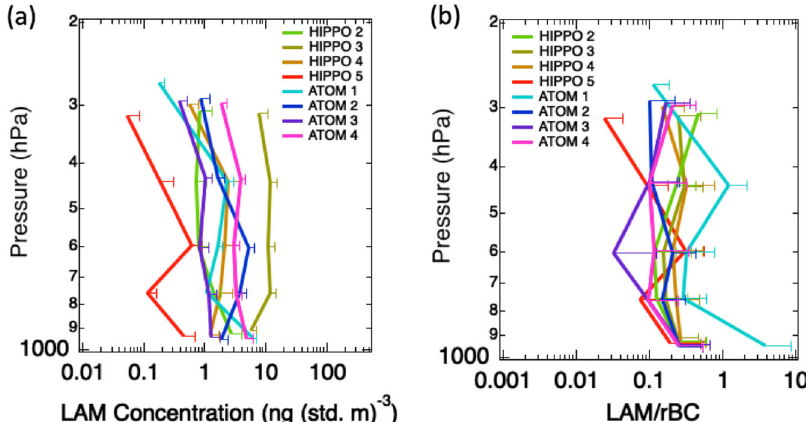
Fig. 4 Seasonality of LAM and LAM/rBC over the N. Hemisphere Paci fi c. Average vertical pro fi les for the remote Paci fi c between 20°N and 60°N for different seasons from the HIPPO and ATom campaigns are shown. LAM concentration ( a ) is given in ng (std. m) − 3 . The total number of observed LAM vertical sampling periods included in the average vertical pro fi le for each campaign is given in parentheses after the campaign name and observation period: HIPPO 2 — Oct./Nov. 2009 (34); HIPPO 3 — March/April 2010 (35); HIPPO 4 — June/July 2011 (36); HIPPO 5 — Aug./Sept. 2011 (35); ATom 1 — July/Aug. 2016 (11); ATom 2 — Jan./Feb. 2017 (31); ATom 3 — Sept./Oct. 2017 (26); ATom 4 — April/May 2018 (22). Observations are binned to 160 hPa, and error bars indicate 1 standard deviation and are only shown for the higher range (assuming observations in a single bin are normally distributed). To determine vertical pro fi les of the ratio of LAM/rBC from observations ( b ), average vertical pro fi les for LAM and rBC are calculated for each season and then divided to determine the ratio at each altitude level, as we assume that remote regions are well-mixed. Error bars for the ratio indicate 1 standard deviation and are determined by propagation of uncertainty, under the assumption that errors between observed LAM and rBC concentrations are